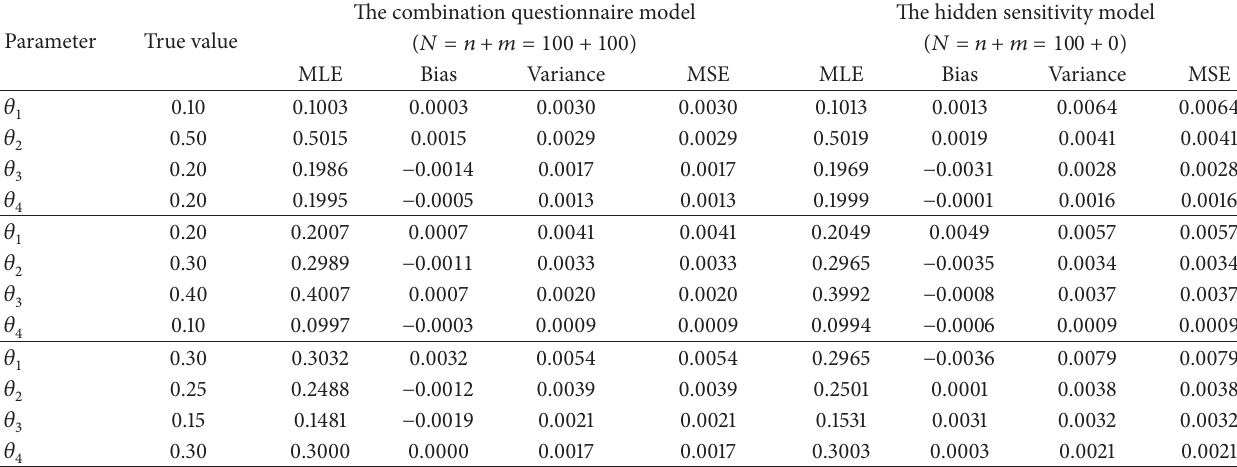
Table 6: Comparison of the efficiency of the proposed combination questionnaire model with that of the hidden sensitivity model of Tian et al. [8] (i.e., the main questionnaire model only) with (𝑝 1 ,𝑝 2 ,𝑝 3 ) = (1/3, 1/3, 1/3) . Parameter True value